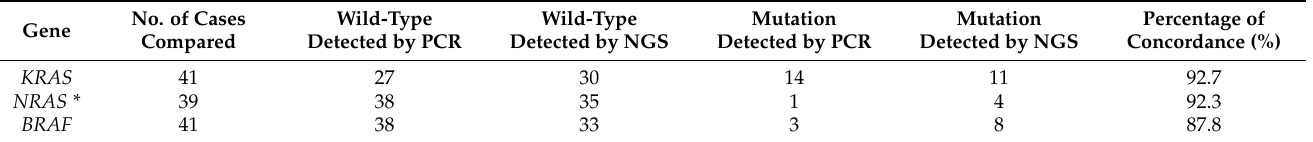
Table 3. Detection of KRAS , NRAS , and BRAF mutation by PCR versus NGS in patients with mCRC.